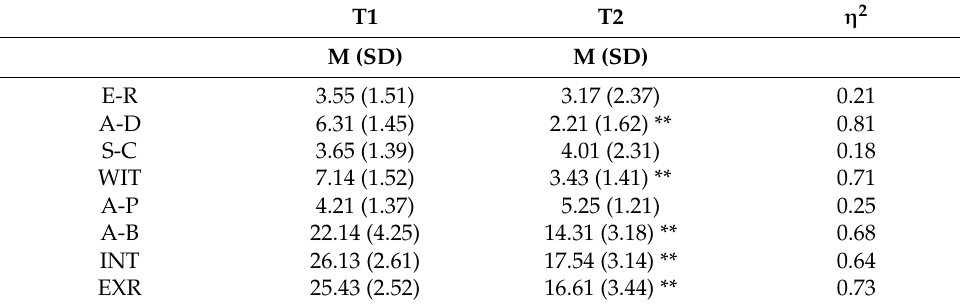
Table 3. Means (standard deviation) of child’s CBCL